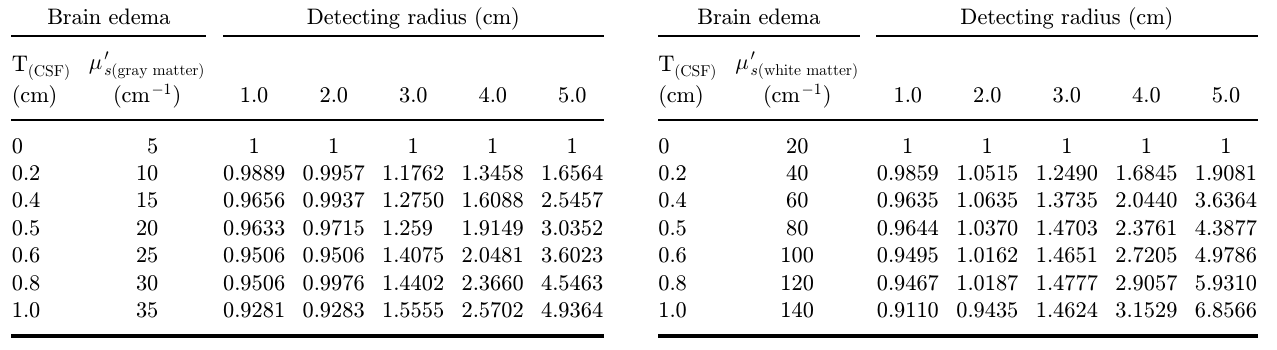
Table 3. The normalized light intensity in Model 2 0 . Brain